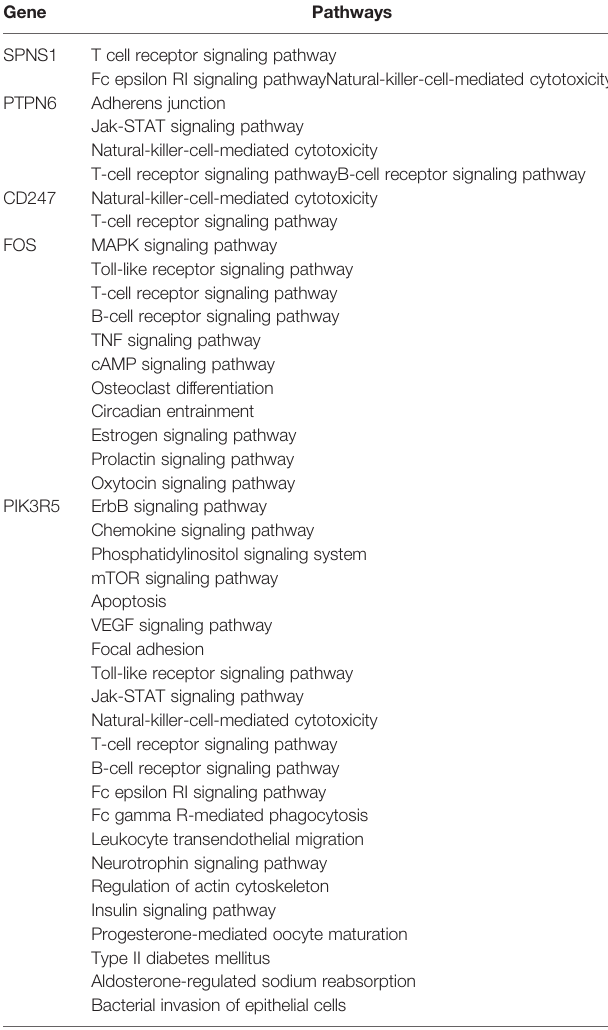
TABLE 2 | Selected gene-speci fi c